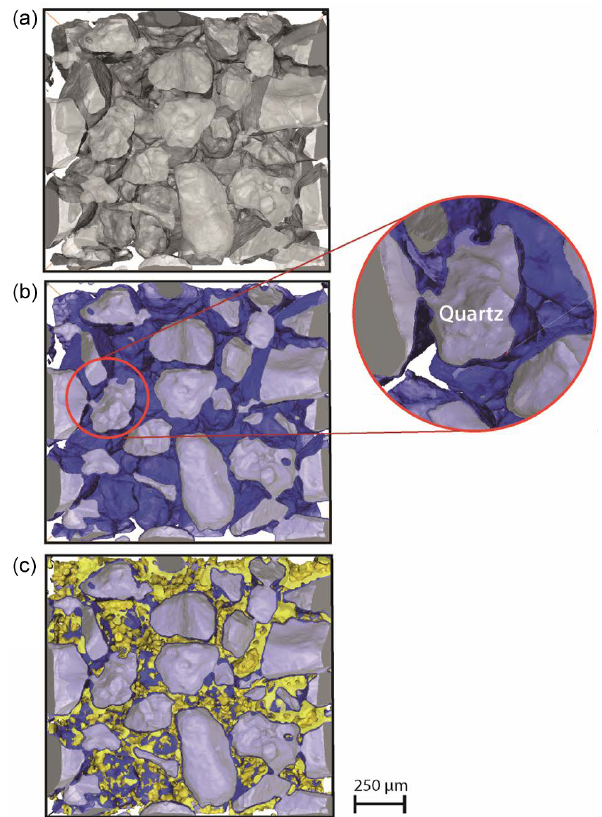
Figure 4. Volume-rendered phases in a representative image sam- ple. For a better visualization the phases are introduced step-by- step, with (a) grains (grey), (b) grains and interfacial water films (blue), and (c) grains, water film and hydrate (yellow). A zoom in (b) shows an interfacial water film measured at 1–4 voxels equiva- lent to 0.38–1.52µm thickness,